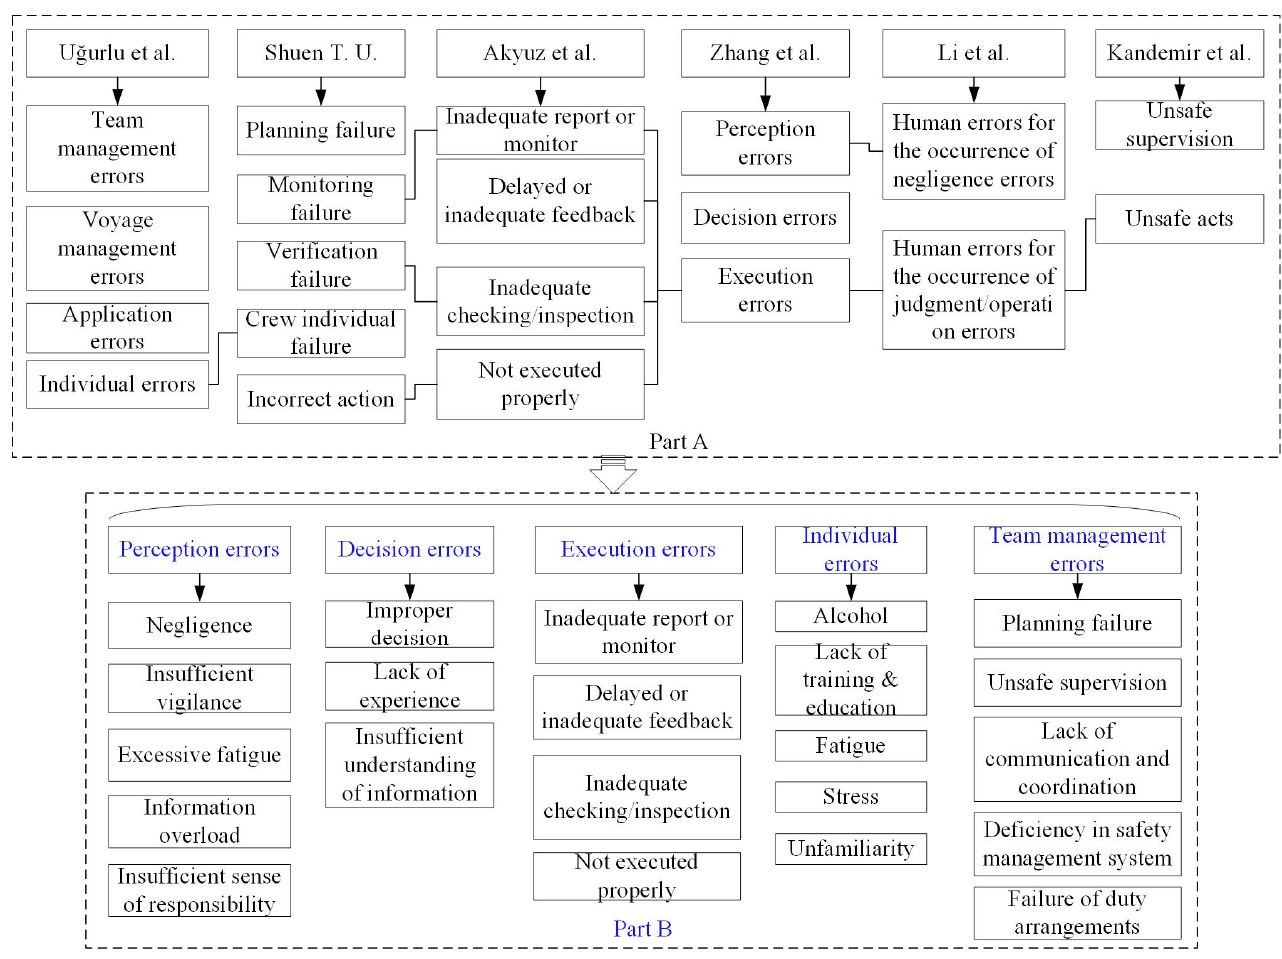
Figure 5. Summary of “human error”.